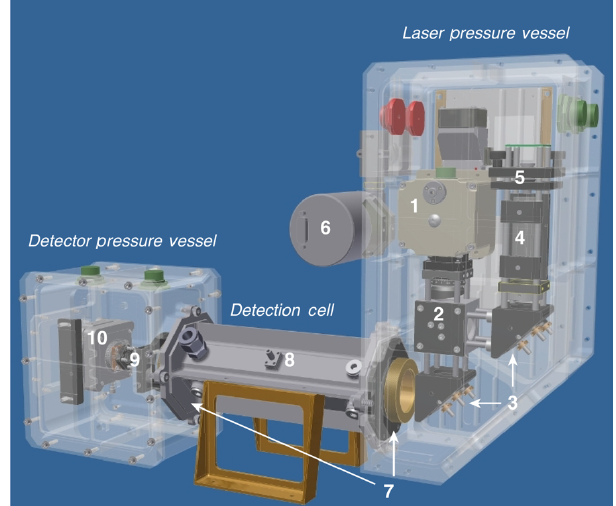
Figure 4. CAD model of N 2 O / CH 4 / H 2 O ICOS instrument shows (1) quantum cascade laser housing, (2) beam splitter, (3) steering optics, (4) Ge etalon, (5) etalon detector, (6) Baratron pressure sen- sor, (7) ICOS cavity mirrors, (8) temperature sensor port, (9) fo- cusing optics, and (10) MCT detector. The detection cell is 25cm